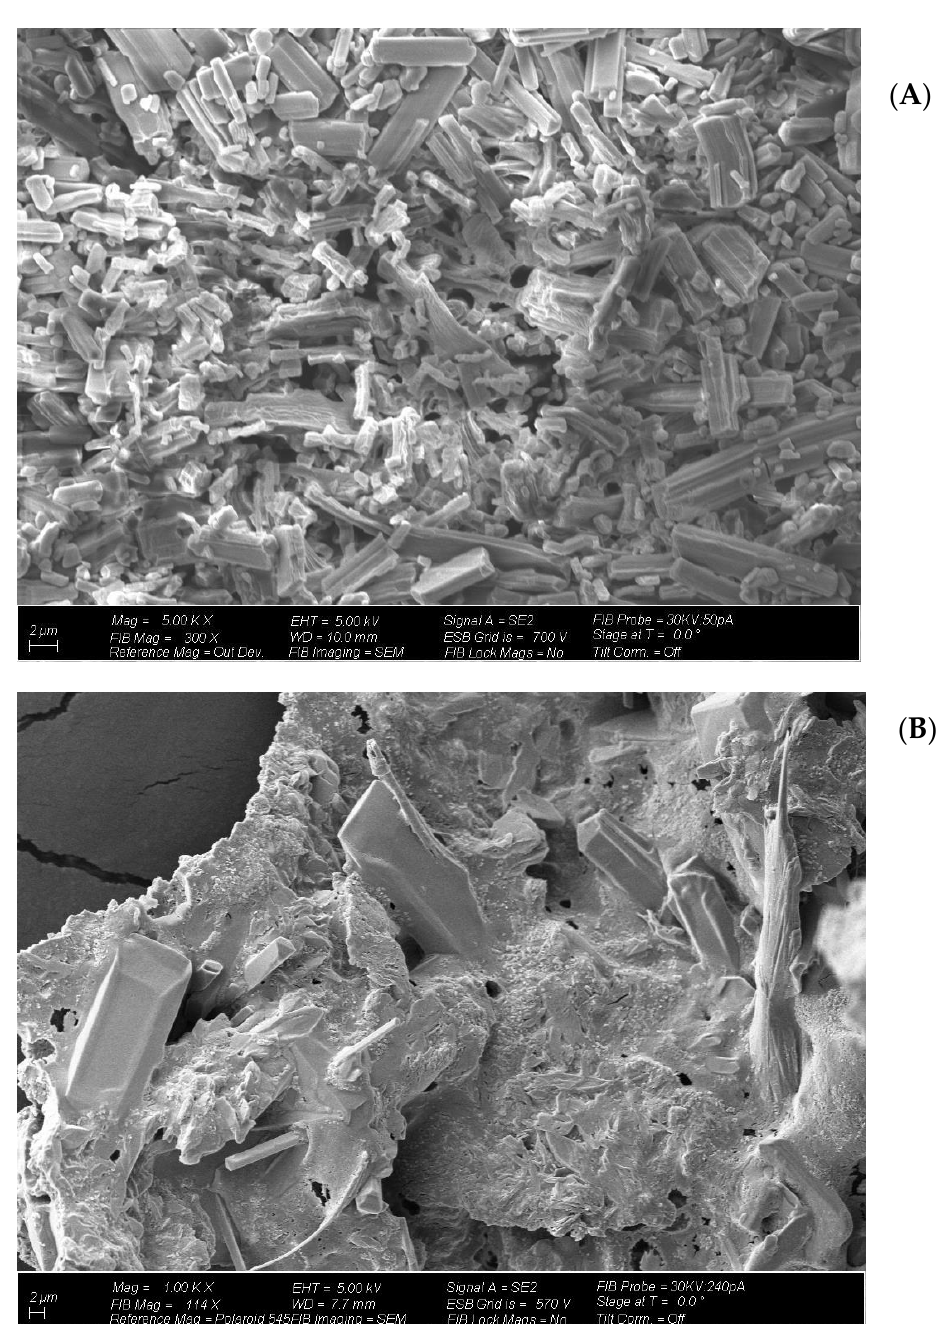
Figure 5. Scanning electron microscope (SEM) image of ( A ) pure NTO solid (5000×) and ( B ) plant exudates (1000×). Distinctive block-like structures were visible when pure NTO particles were examined. The presence of block-like structures was seen in plant exudates, which showed that NTO is a part of the exudates.